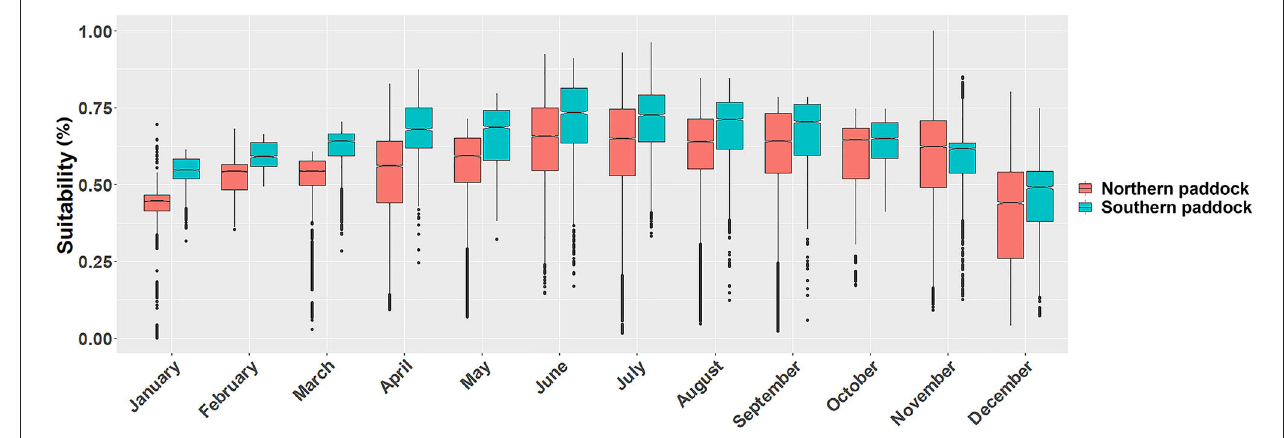
FIGURE 3 | Monthly P. insidiosum suitability distributions. Each box-and-whisker plot represents the monthly suitability values for each grazing paddock. Y-axis represents the weighted distribution where the suitability distribution was simplified by dividing it by the number of cells (30m resolution) of each paddock.